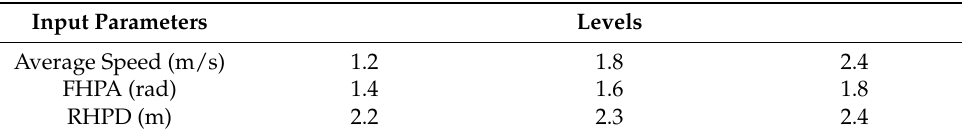
Table 1. Input parameters and their